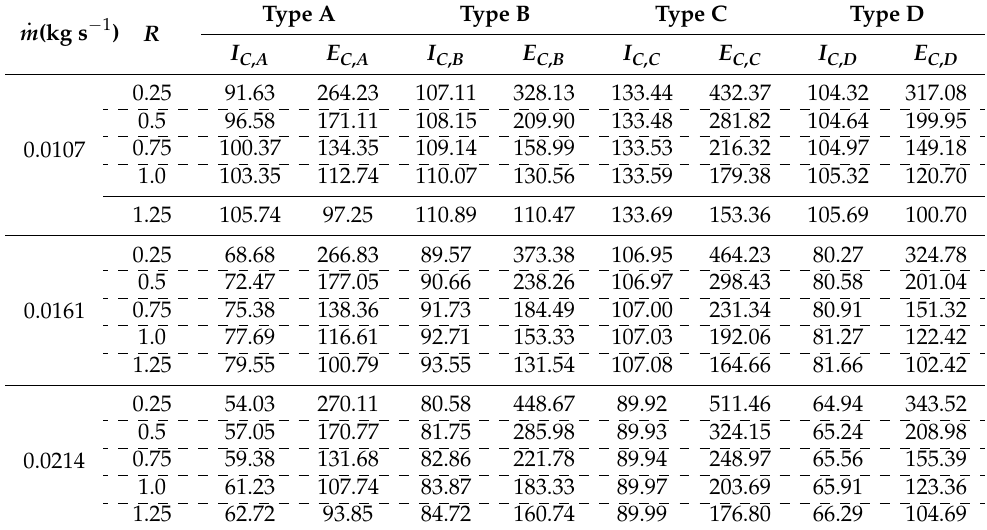
Table 7. Theoretical predictions of collector efficiency improvements and further collector efficiency enhancements with I 0 = 1100 W/m 2